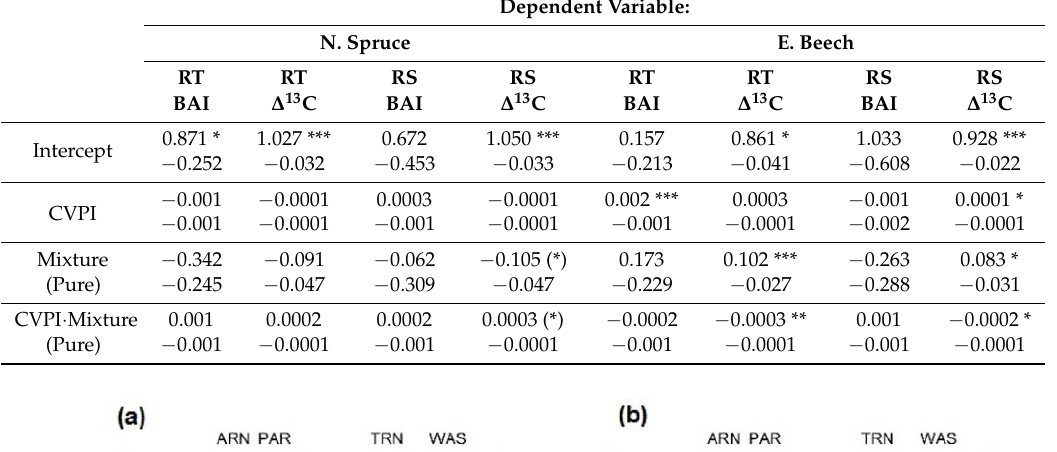
Table A1. Estimates of the linear mixed effect model of spruce and beech in monospecific and mixed stands along the precipitation gradient (CVPI) (spruce n = 45; beech n =41). Standard deviation is represented in brackets. Significance codes: ‘***’ 0.001 ‘**’ 0.01 ‘*’ 0.05 ‘(*)’ 0.1.